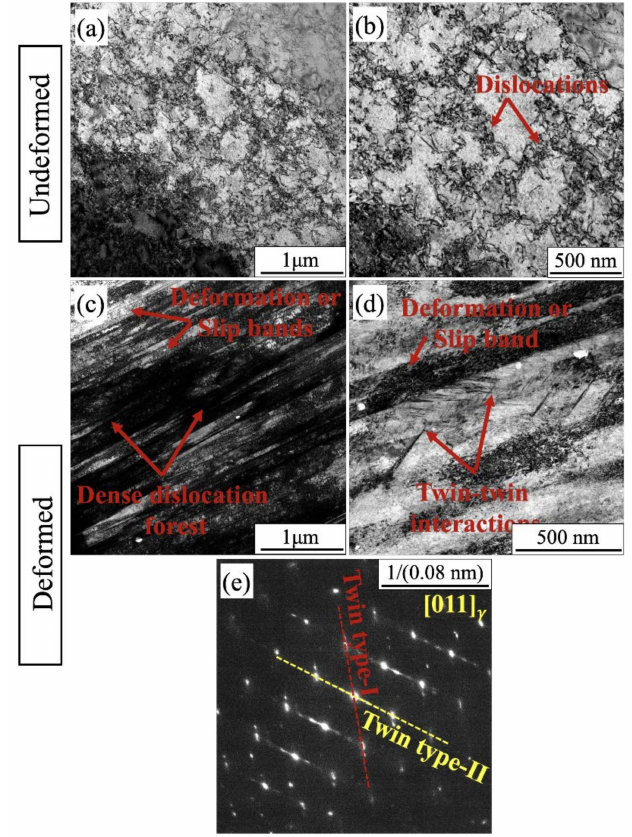
Figure 11. ( a ) Bright field (BF) TEM image of the microstructure adjacent to failure region; ( b ) magni- fied view of the selected area; ( c ) BF image showing dense dislocation forest and deformation bands; ( d ) magnified view of selected location; ( e ) selected area electron diffraction of the corresponding location from area in ( d ).